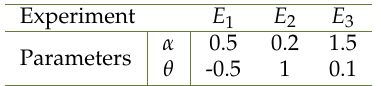
Table 1. Default value for